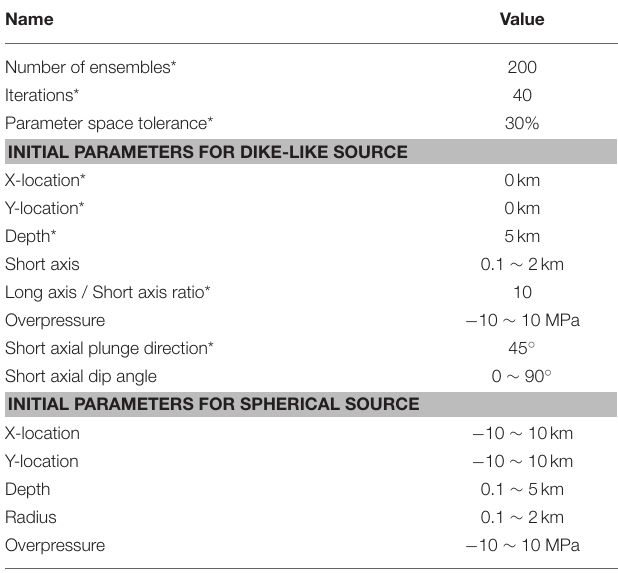
TABLE 1 | Parameters of the Ensemble Kalman Filter. TABLE 2 | Physical properties for calculating the analytical models and the Coulomb